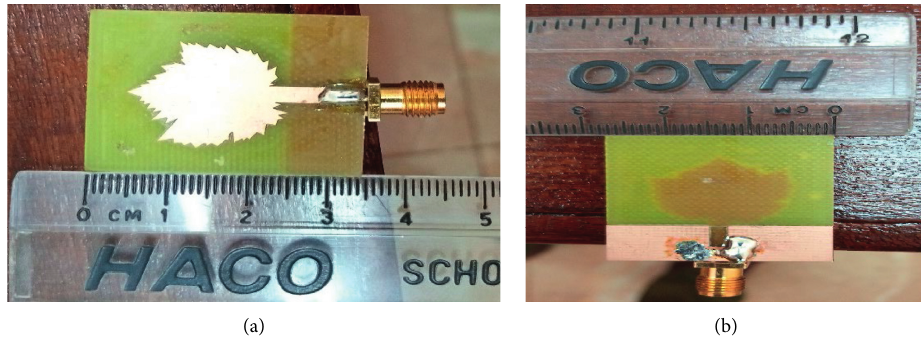
Figure 8: The prototype of the proposed VBi-UWBA (a) top layer and (b) ground plane.